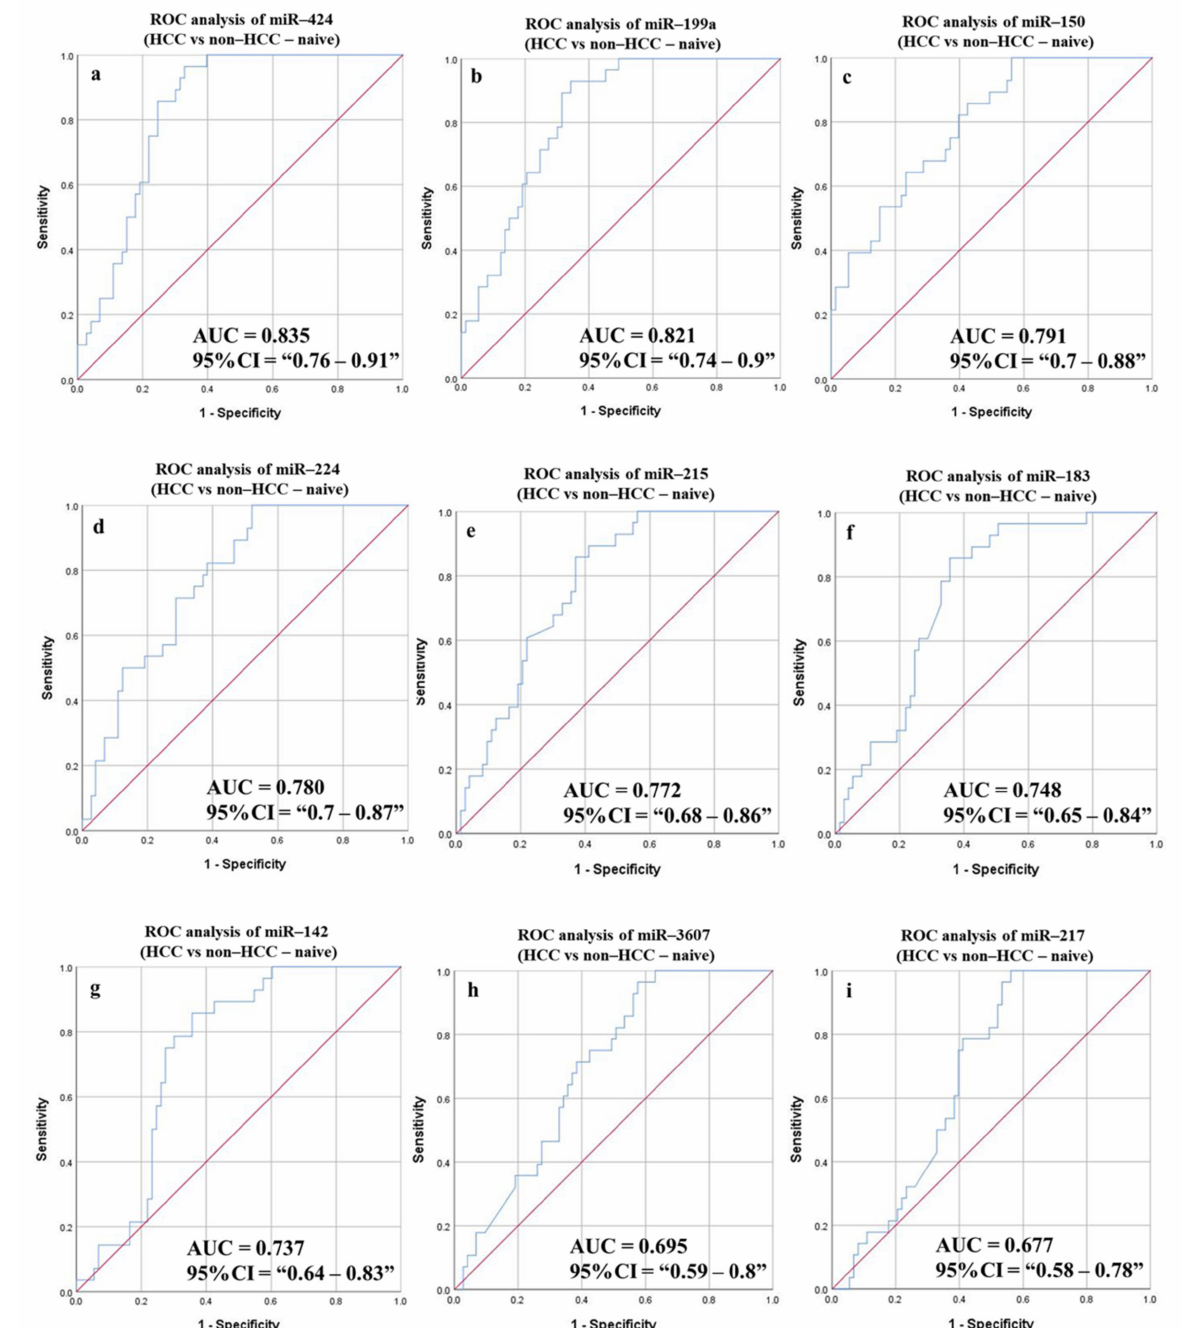
Figure 10. ROC curves and AUC for the DE-miRNAs to differentiate between HCC (treatment naive) patients and non-HCC (healthy controls, non-cirrhotic (treatment naive), and cirrhotic (treatment naive) HCV patients). The diagnostic potential and AUC of nine DE-miRNAs [( a ) miR-424 ( b ) miR- 199a ( c ) miR-150 ( d ) miR-224 ( e ) miR-215 ( f ) miR-183 ( g ) miR-142 ( h ) miR-3607 and ( i ) miR-217] were calculated. (DE: Differentially expressed, HCC: Hepatocellular carcinoma, ROC: Receiver operating